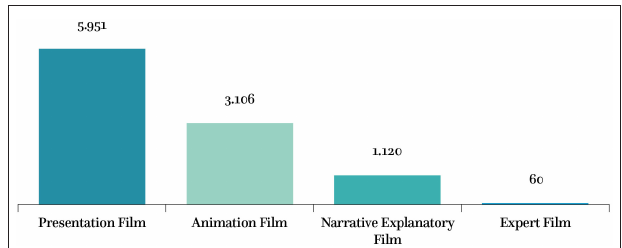
FIGURE 1 | Average views per day distributed among the video types ( n =